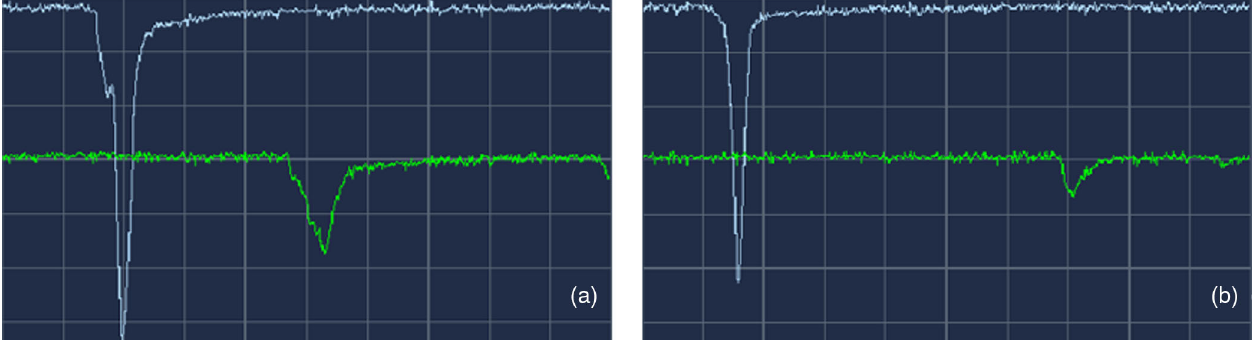
FIG. 13. Signals from PMT1 (green trace, upstream end of fiber) and PMT2 (blue, downstream end); 200 ns = div and 1 V = div into 50 Ω . The loss points are (a) 82 and (b) 39 m upstream of the beam stopper at the downstream end. As losses move downstream, the peaks move rightward for PMT1 but leftward for PMT2, and the ratio of their amplitudes PMT1/PMT2 decreases. The pulse widths and peak separations of PMT2 are compressed by 5 relative to PMT1.